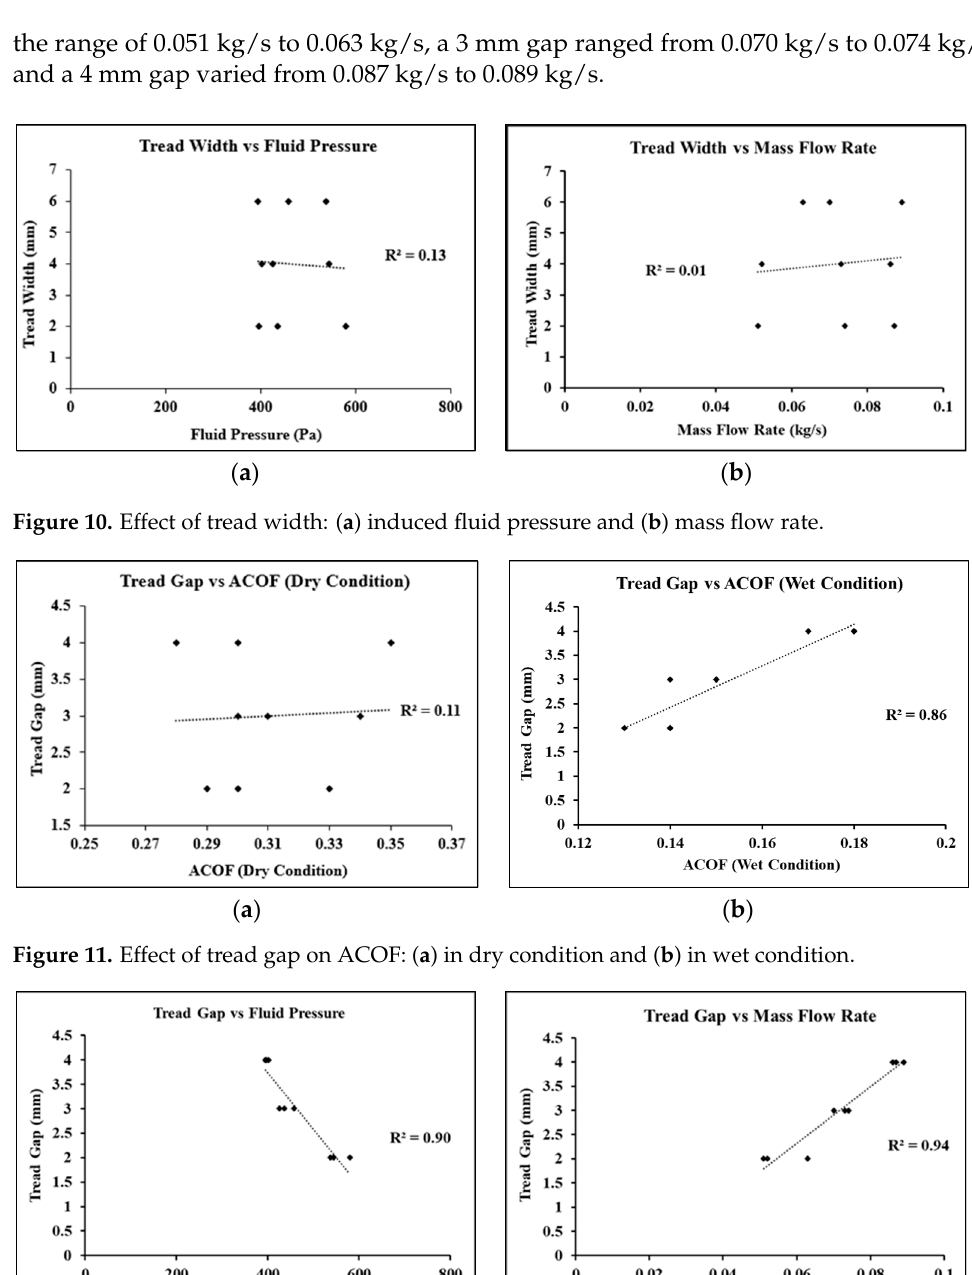
Figure 9. Effect of tread width on ACOF: ( a ) in dry condition and ( b ) in wet condition.